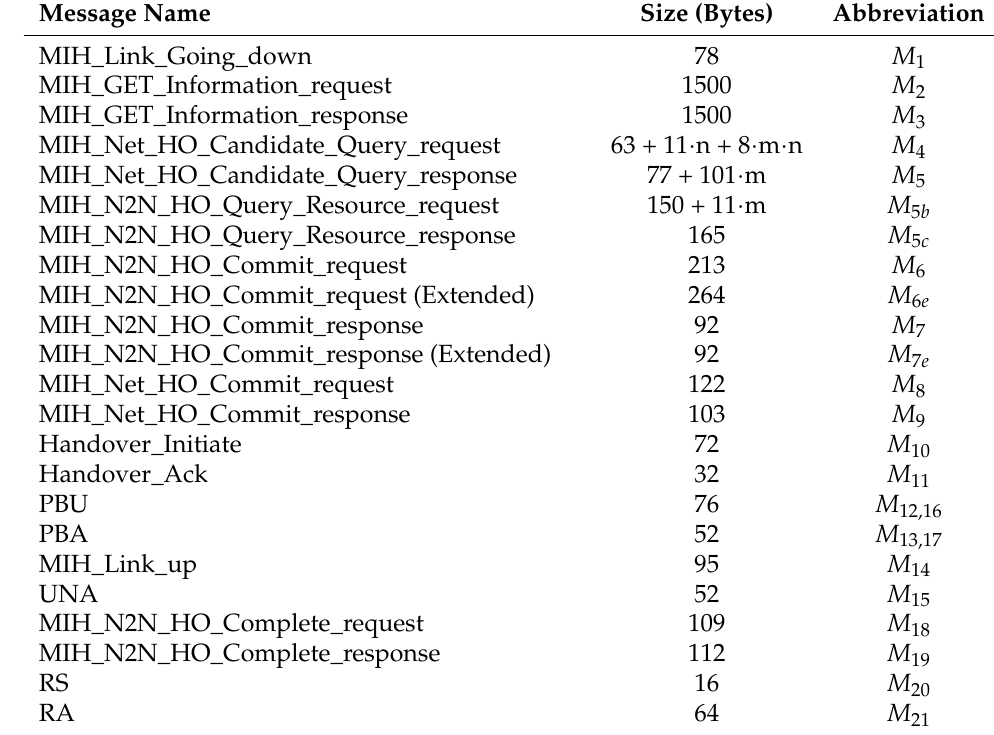
Table 7. The cost of each message exchanged during the signaling process.